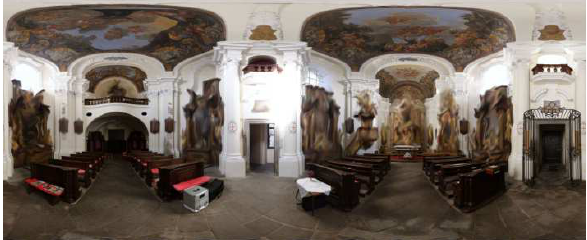
Figure 6. Panoramic image of the St. Francis Xavier